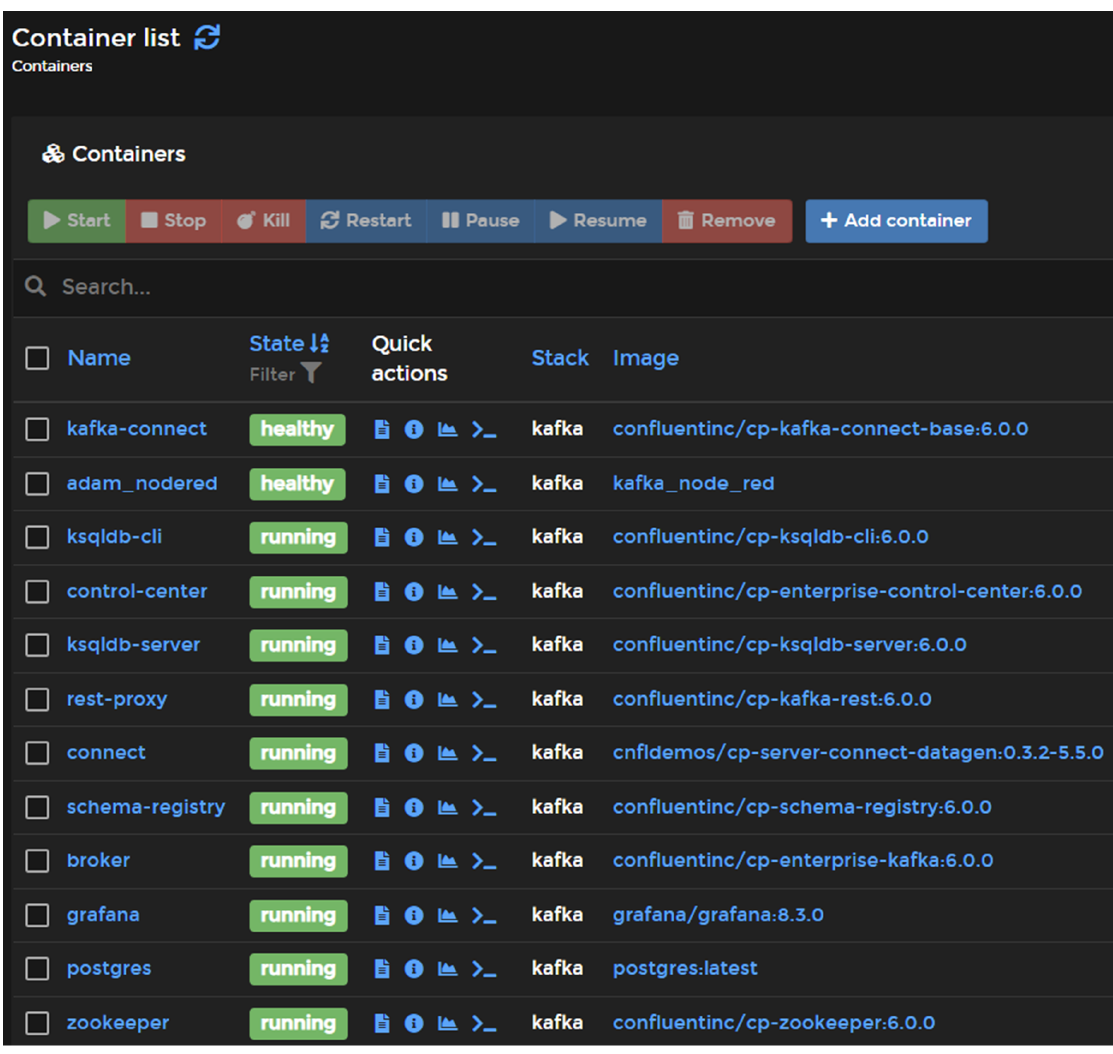
Figure 5. Docker (Portainer) containers.